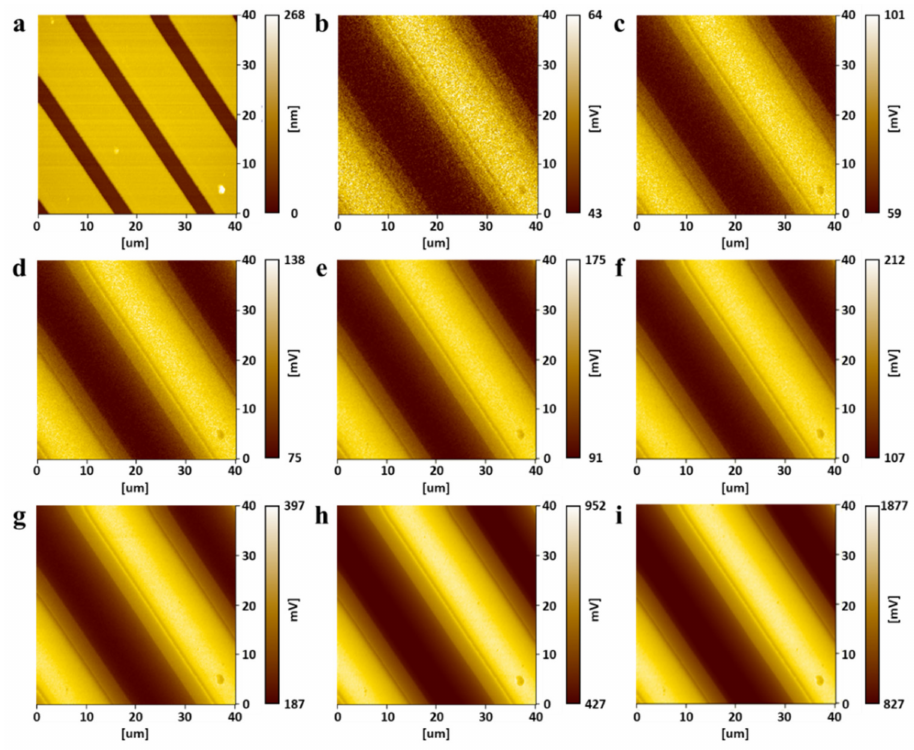
Figure 12. The ToGoFET images obtained using synchronous detection: ( a ) topographic image, and ( b – i ) local electrical images at different input voltages (( b ) 20, ( c ) 40 mV pp , ( d ) 60 mV pp , ( e ) 80 mV pp , ( f ) 100 mV pp , ( g ) 200 mV pp , ( h ) 500 mV pp , and ( i ) 1000 mV pp